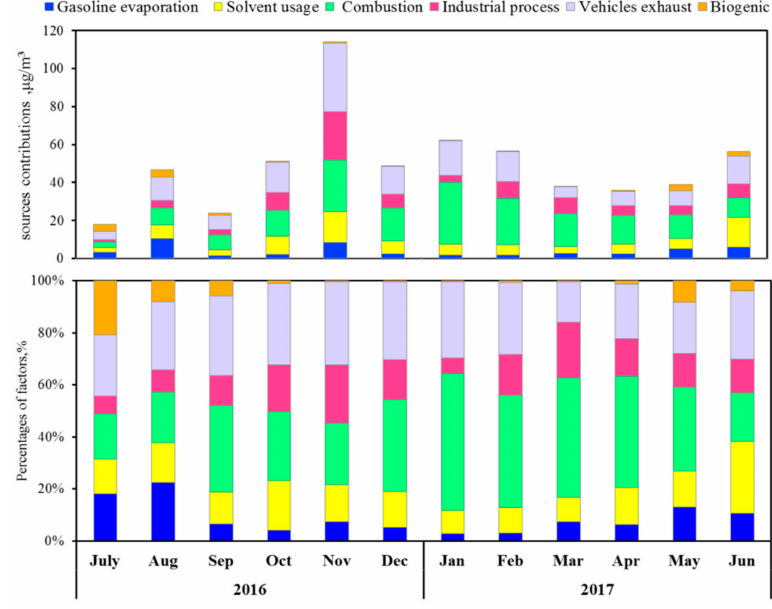
Figure 7. Seasonal variations in the average relative contributions of VOCs